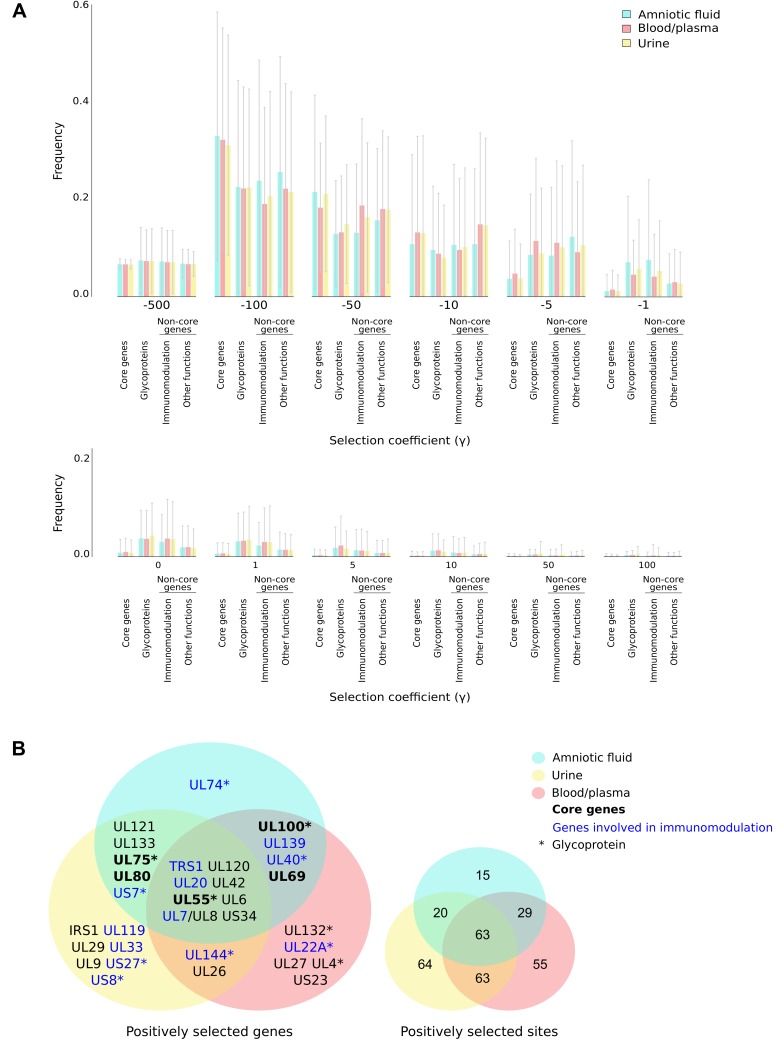
Selective patterns in HCMV clinical isolates from different compartments.(A) Distribution of selection coefficients (γ) for all coding genes of HCMV clinical isolates sampled from amniotic fluid, urine, and blood/plasma. Selection coefficients were calculated for all codons and genes were grouped on the basis of their conservation (core, non-core/sub-core) and of the functional classification of the encoded protein (glycoprotein, both core and non-core; immunomodulation, non-core only). Large error bars are caused by the difficulty in determining the relative frequency of similar selection coefficients. (B) Venn diagrams of positively selected genes and sites in HCMV isolates.